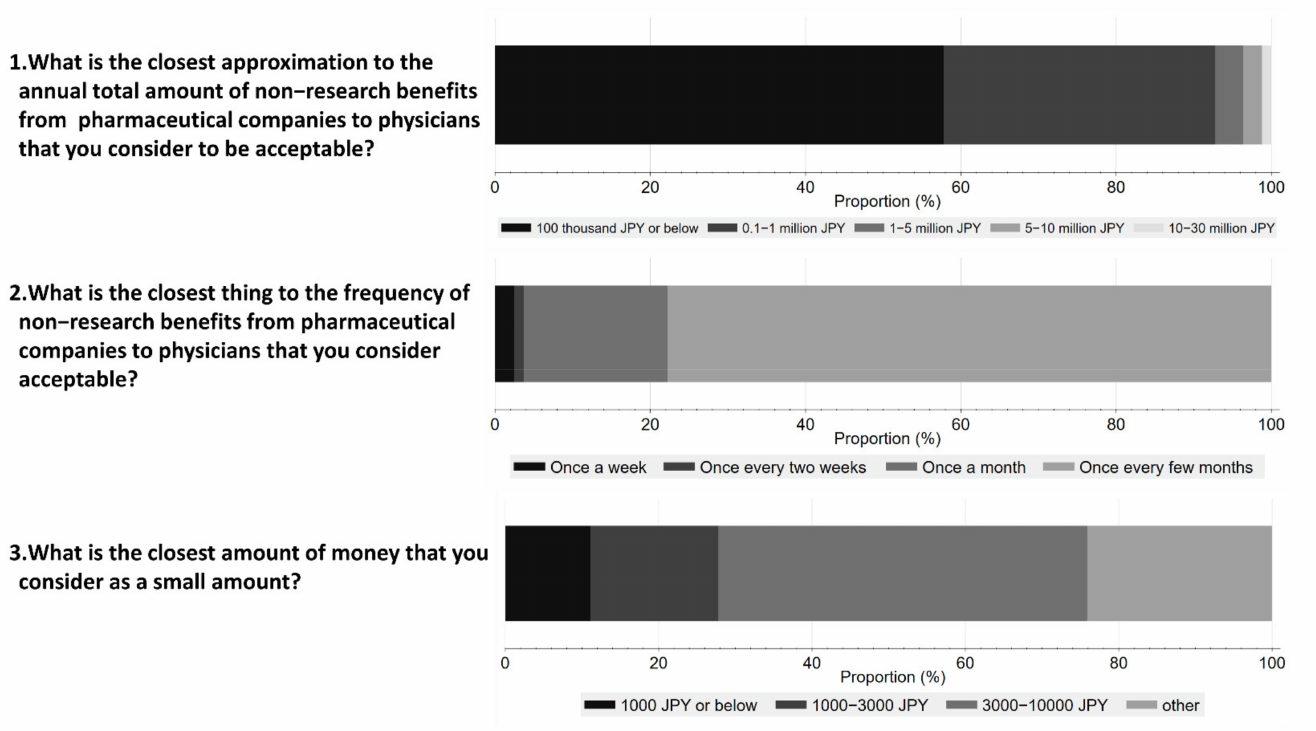
Figure 4. Respondents’ perception of acceptable amounts and frequency of non-research payments from pharmaceutical companies to